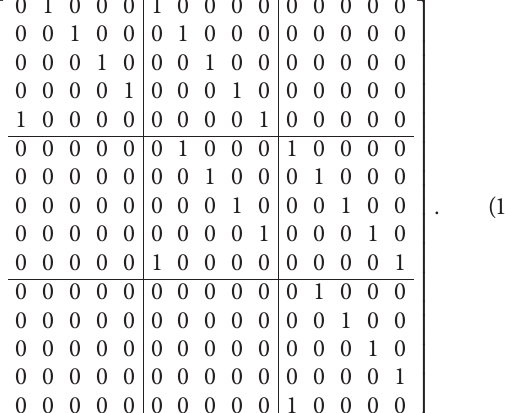
Figure 1: 𝐶 5 × 𝑃 3 =